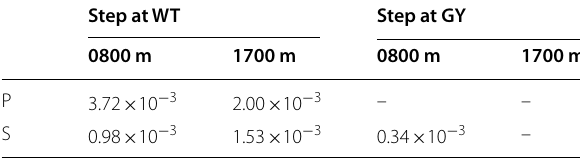
Table 2 (cid:31) Q − 1 corresponding to the amplitude ratio Step at